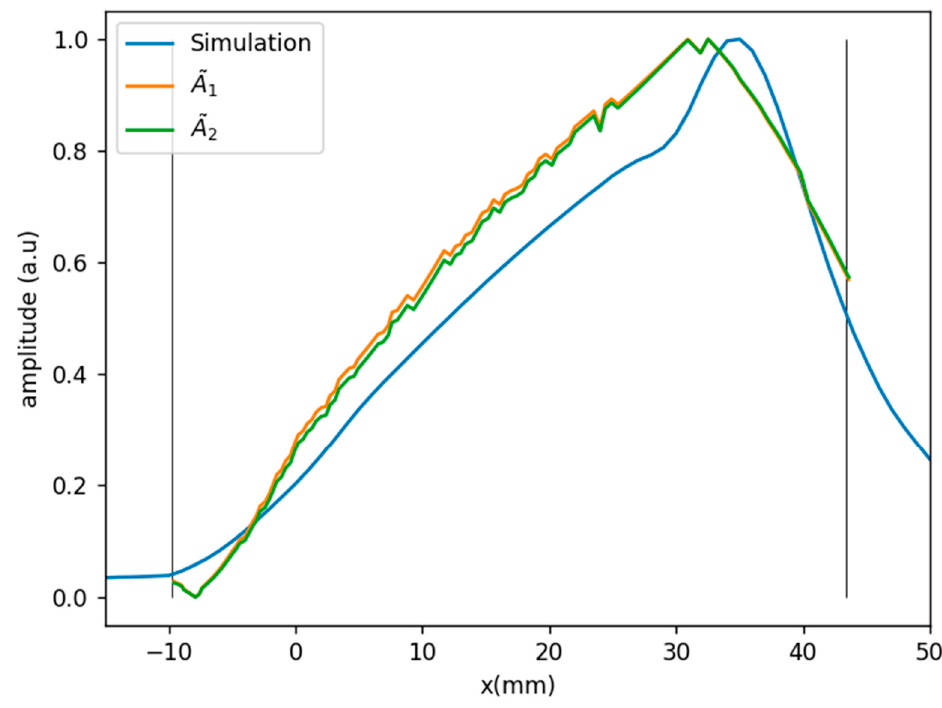
Figure 5. Amplitude distribution along wavefront according to simulation and simplified approximations.